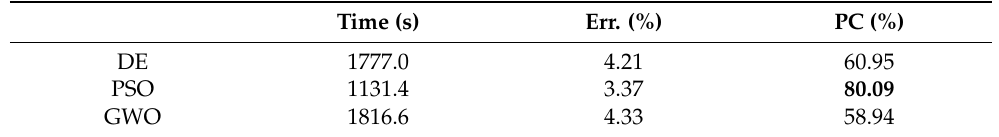
Table 4. Different optimization algorithms outcomes with multiple failures [10]. The values related to best performing algorithm (PSO) are highlighted in bold, along with the relative